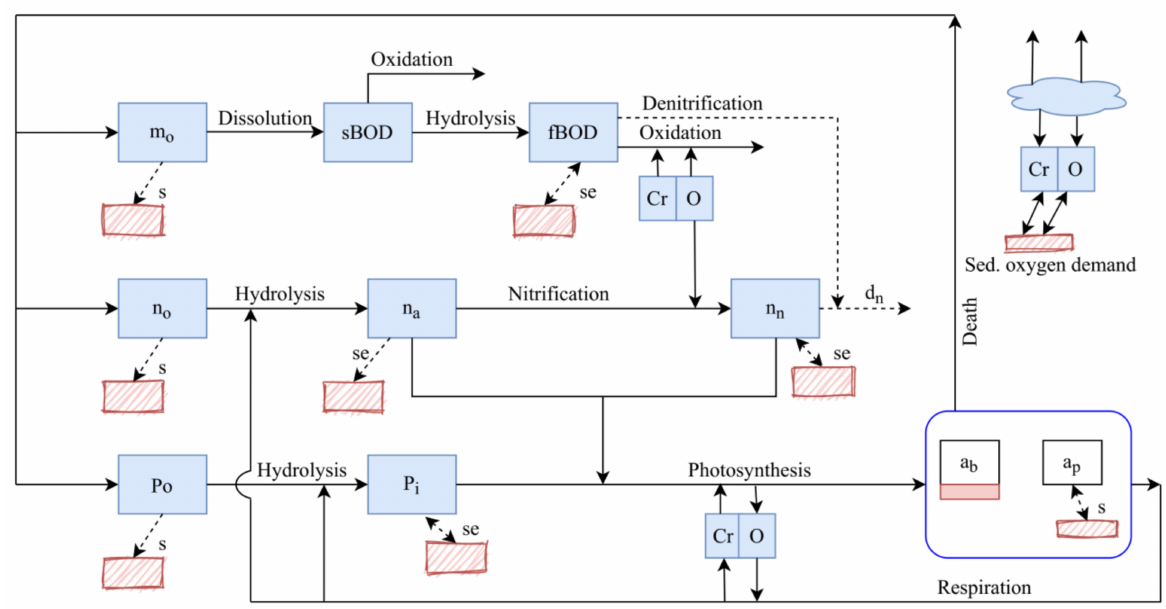
Figure 2. Schematic diagram of interacting water quality state variables in QUAL2Kw (a b : bottom algae, a p : phytoplankton, m o : detritus, sBOD: slow CBOD, fBOD: fast CBOD, se: sediment exchange, dn: denitrification, Cr: inorganic carbon, DO: dissolved oxygen, n o : organic nitrogen, n a : ammonia nitrogen, n n : nitrate nitrogen, p o : organic phosphorus and p i : inorganic